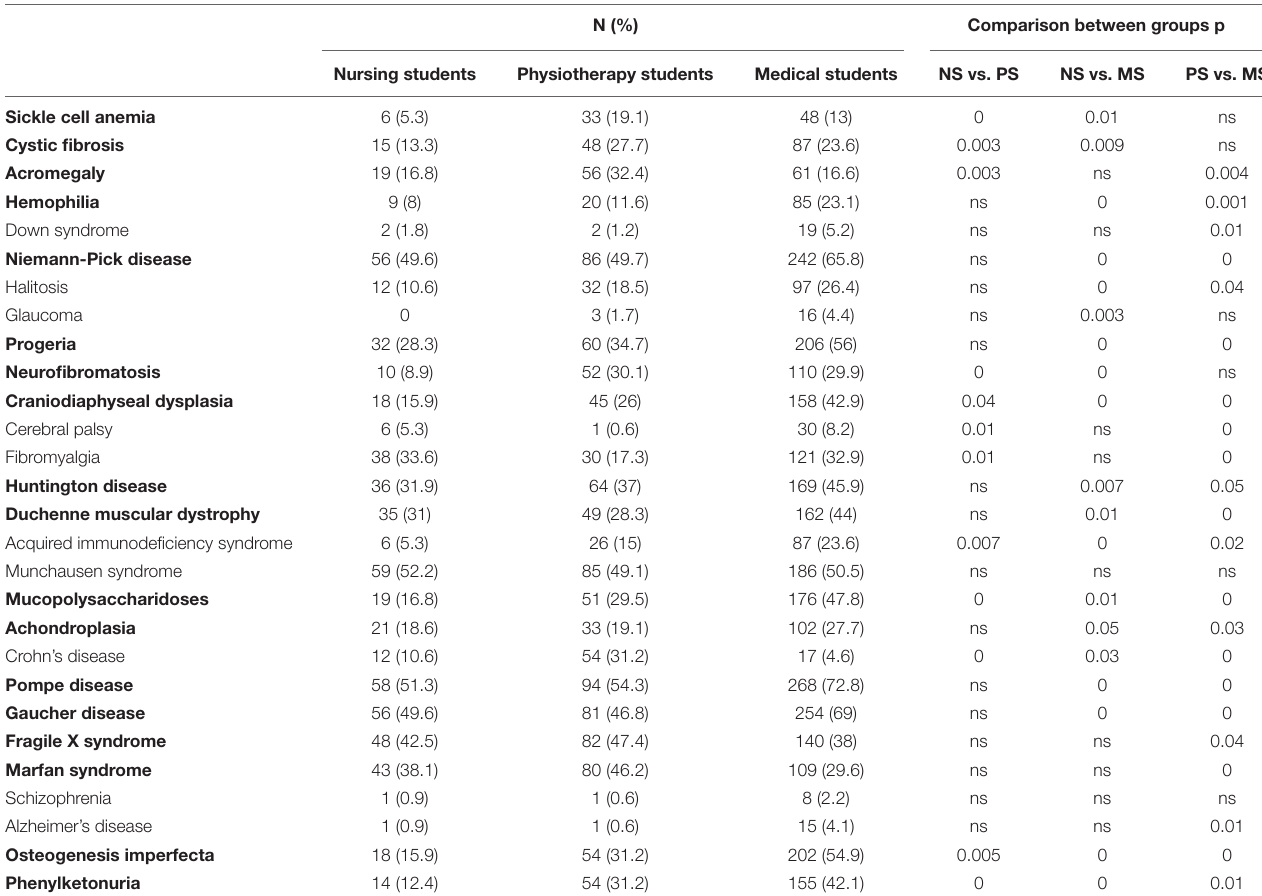
TABLE 3 | Which of the following diseases are considered to be rare in Poland?